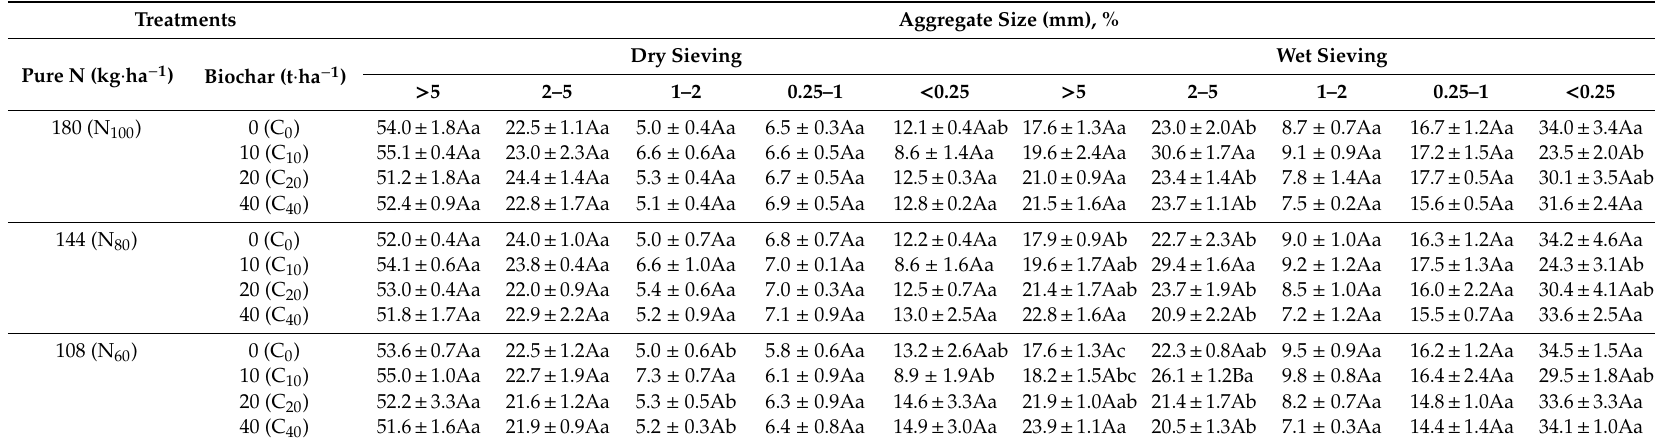
Table 2. The e ff ect of biochar and nitrogen fertilizer on content and distribution of soil aggregates.